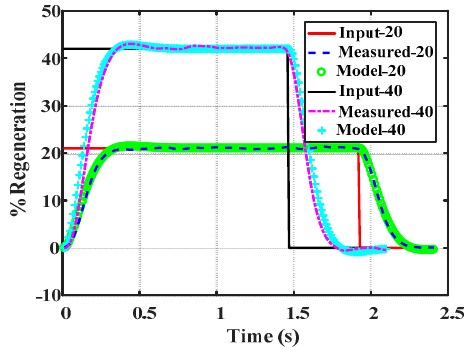
Figure 3. Real and simulated response to step input.